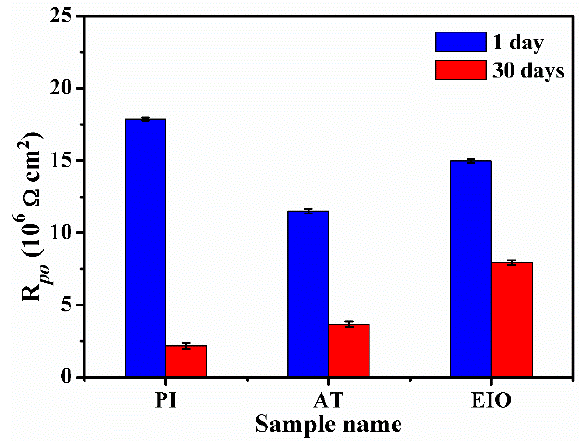
Figure 8. Coating pores resistance values of the PI, AT, and EIO coatings immersed in 3.5 wt.% NaCl solution for 1 day and 30 days.